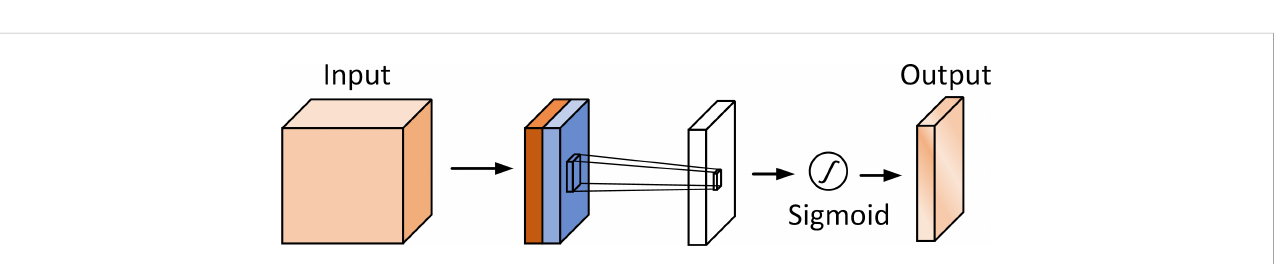
FIGURE 7 The structure of the spatial attention module.